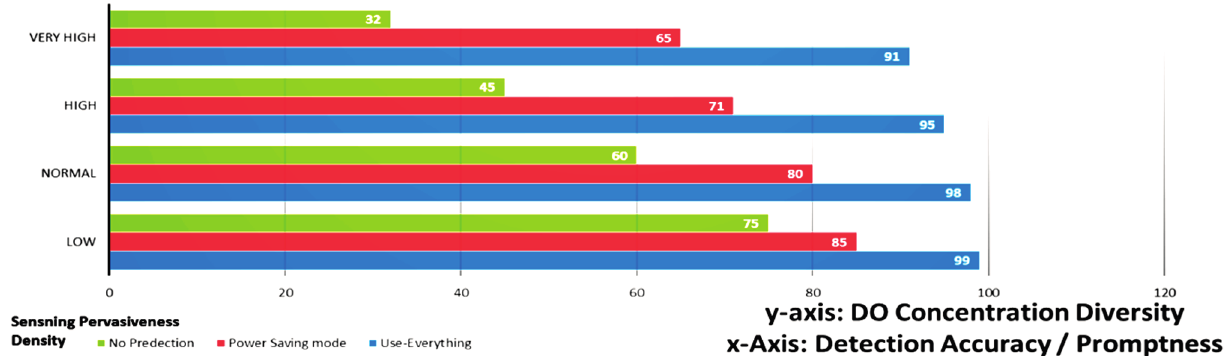
Figure 8. Detection effectiveness (accuracy/ promptness).